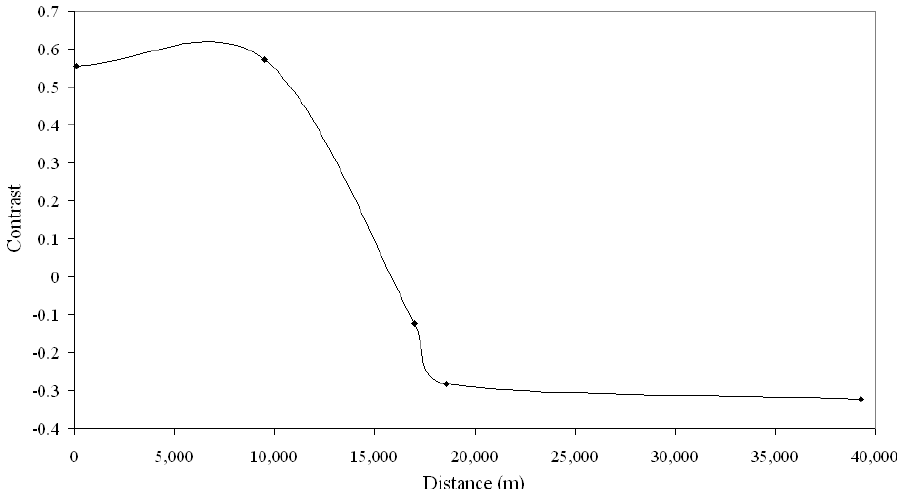
Figure 5. Contrast values (C) obtained from the “weights of evidence” analysis showing the relationship between deforestation (“current forest to unstocked forest” change) and “distance to main